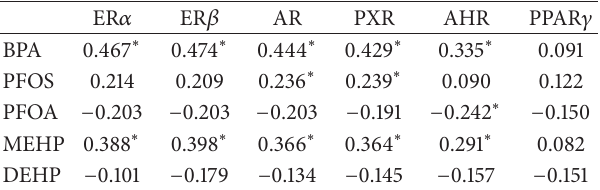
Table 3: Correlation between ECD and receptor expression in infer- tile group.